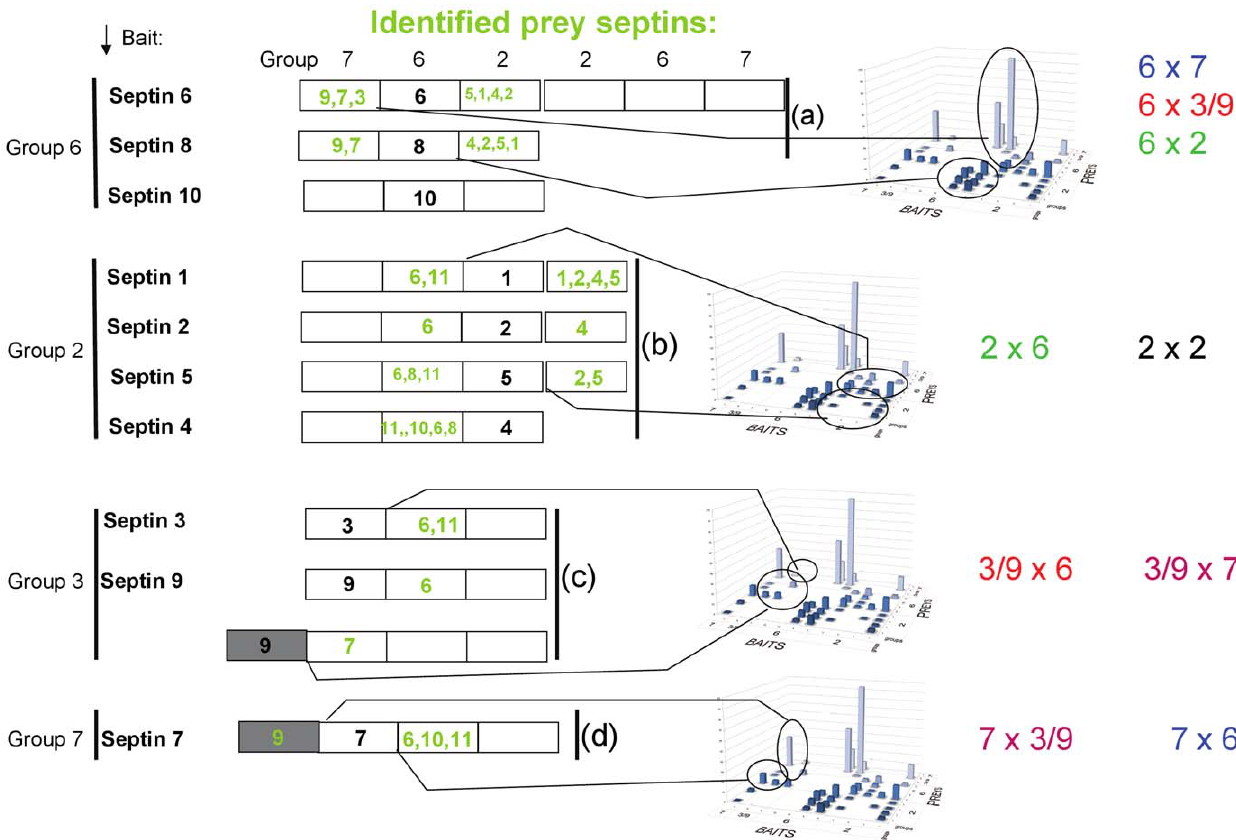
Figure 3. Representation of the two-hybrid septin-septin results in the light of the format of the trimer/hexamer SEPT7/SEPT6/ SEPT2 – SEPT2/SEPT6/SEPT7 [ 18 ] . Assuming that members of the same group may serve as substitutes [6] and taking into account the structural arrangement found for the crystal of the trimer/hexamer SEPT 7/6/2, interesting observations can be made. The bait septins employed in the two- hybrid system are given on the left. In green in the schematic figure the preferentially found prey septins are indicated and assigned to likely positions in the hexamer scheme. The three dimensional column diagrams on the right refer to Fig. 2. The data that differ significantly from a random distribution have been circled to indicate the experimental basis on which each structural arrangement (monomer interfaces) is based. From top to bottom: (a) is based on the following statistical comparison: group 6 vs. group 2 (no random distribution: p , 0.001), group 6 vs. group 3/9 (p , 0.001), group 6 vs. 7 (p , 0.001). (b): group 2 vs. group 6 (p , 0.001), (c): group 3/9 vs. group 6 (p , 0.001), group 7 vs. group 9/3 (p , 0.001), (d): group 7 vs. group 6 (p , 0.001), group 7 vs. group 9/3 (p , 0.001). None of the septins fished members of its own family, except group two members (b). The group pairings with statistically significant clone distributions were indicated at the right side of the figure (e.g. 6 6 7, 3/9 6 6 etc.). By comparison of the letters color codes it can be seen that all of these group pairs were reciprocal. For example bait septin 6 group fished group 2 septins (a) and vice versa (b) (p , 0.001). As initially proposed by Kinoshita there may be substitutions among different members of the same septin group. The sequence of listed septins from left to right reflects a descending order of frequency of clones with septins that were found to interact (e.g. for SEPT6 bait: 9,3,7 and